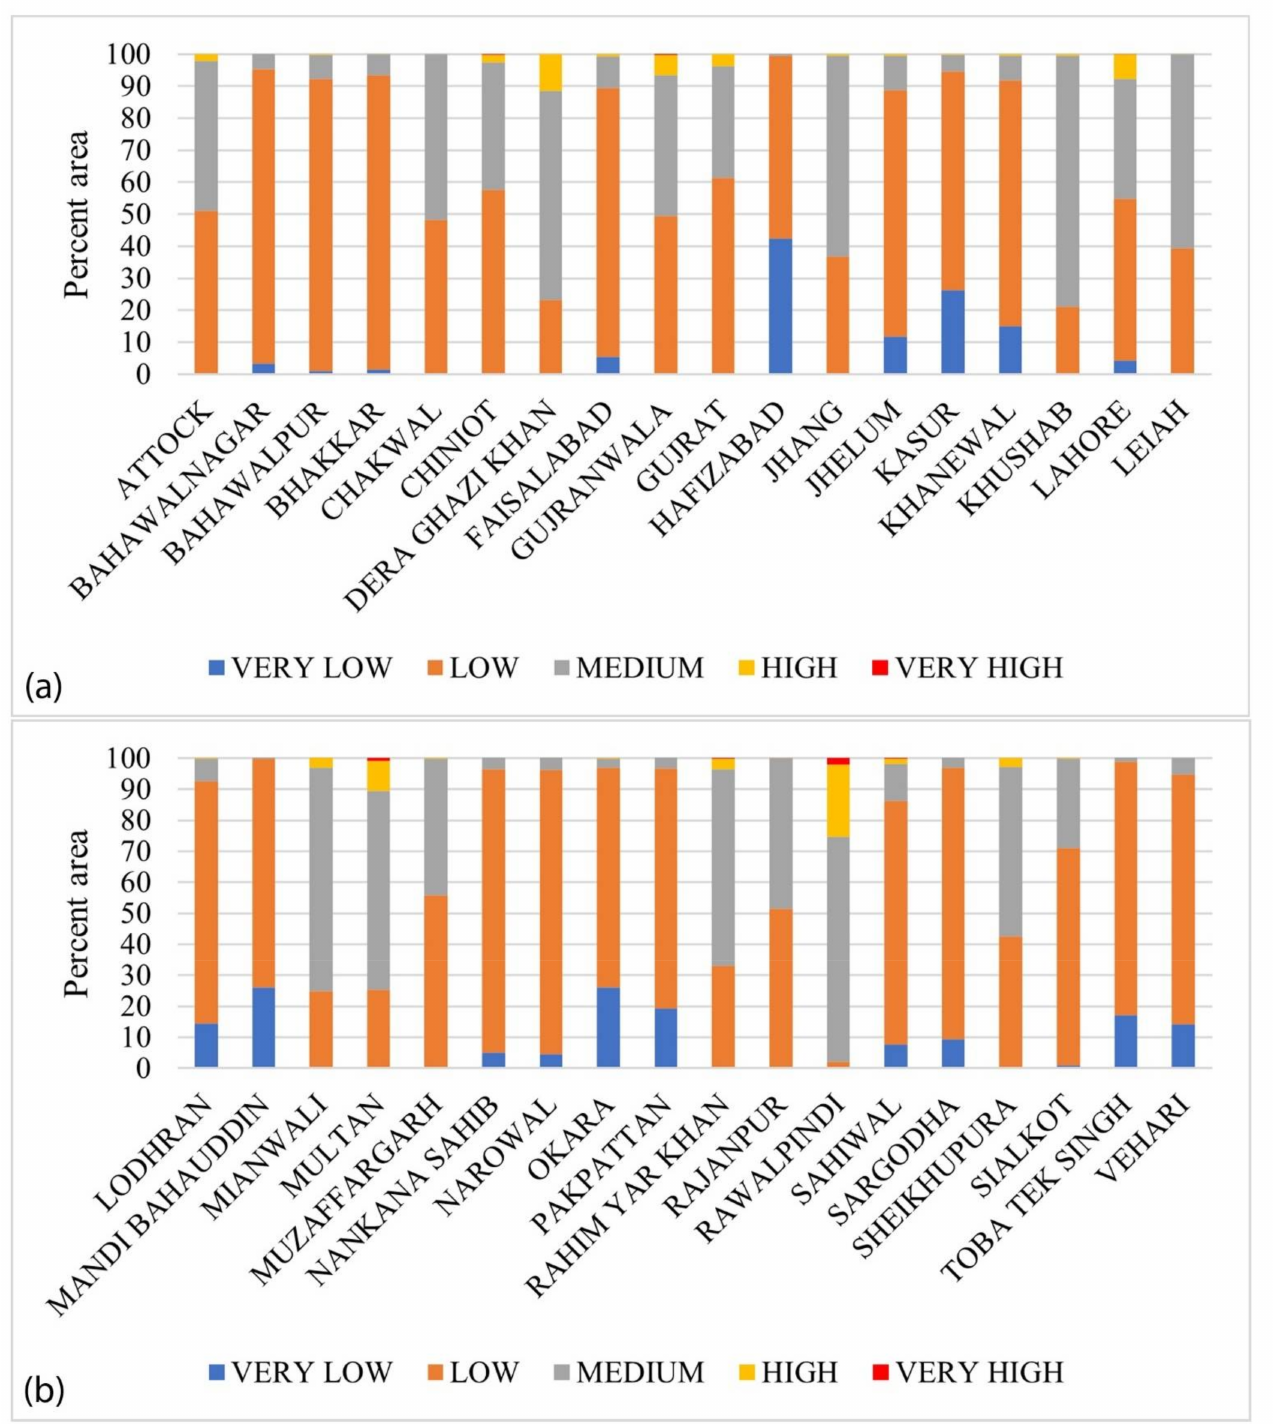
Figure 8. Percentage-wise EVA results for districts of Punjab province: ( a ) 1–18 districts; ( b ) 19–36 districts. Bahawalpur region shows a peak under the ‘low’ vulnerability zone, with ‘low’ vulner- ability covering 91.27% of its total area. The reason for this result is that the Bahawalpur re- gion has the largest desert in Pakistan, most of the area being barren and uncultivated [111]; therefore, all the chosen indicators collectively did not contribute significantly, and the region yields low